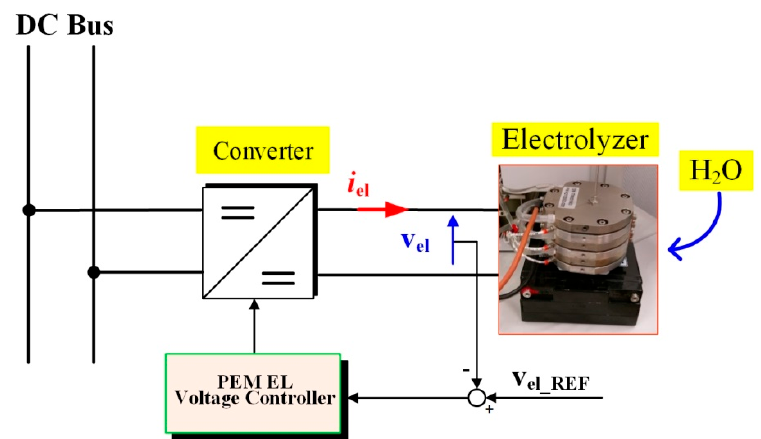
Figure 5. system of the converter connected with a PEM EL.